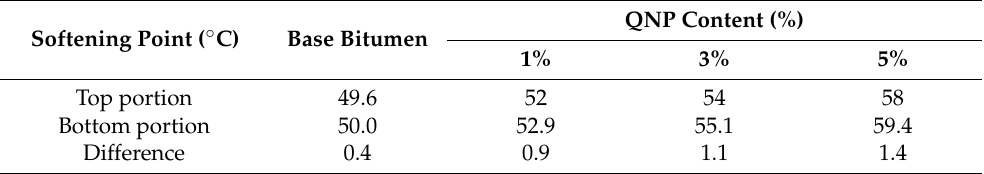
Figure 4. SEM images of ( a ) 0%, ( b ) 1%, ( c ) 3%, and ( d ) 5% QNP bitumen. Table 4. Storage stability test